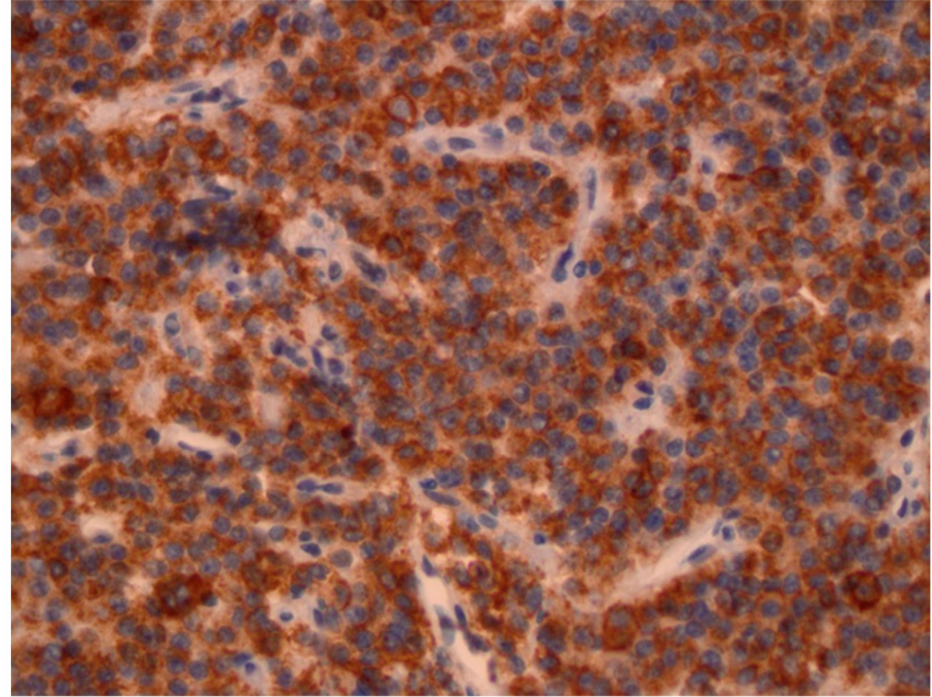
Figure 1. Immunohistochemical staining for growth hormone was positive in nearly all cells of the adenoma. A dense, granulated pattern was observed in this specimen (patient